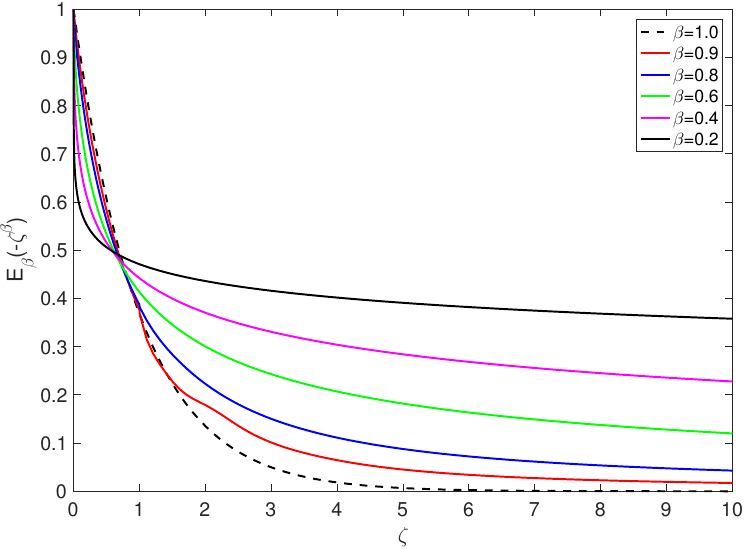
Figure 1. Plots of Mittag-Leffler function E β ( − ζ β ) for various β values. For β = 1 (dashed line) the standard exponential decay is recovered. Linear axes.